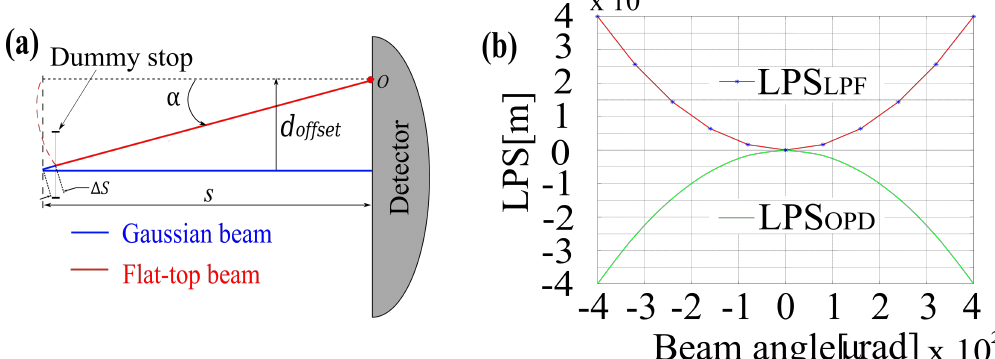
Figure 4. ( a ) The flat-top beam is placed with a transverse offset d of fset and a tilt angle α around the pivot O on the detector. The dummy stop only works for flat-top beam and its center is always at the starting point of flat-top beam. There is no geometric path difference between the two beams in this case. ( b ) The upper part is the numerically computed LPS LPF results for interference between the flat-top beam and the Gaussian beam on the detector with an initial offset between the two beam centers. The lower part is analytically computed the geometric optical path difference LPS OPD